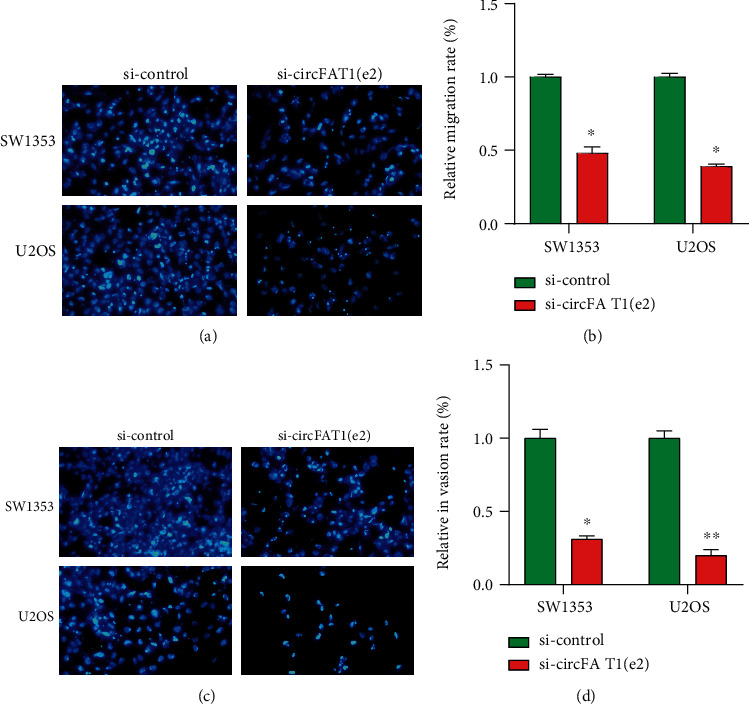
CircFAT1(e2) facilitated osteosarcoma cell migration and invasion. (a, b) In the migration experiments on SW1353 and U2OS cells, the migration rate of circFAT1(e2) knockdown cells decreased by 50% compared with the control group. (c, d) In the SW1353 and U2OS cell invasion experiments, the invasion rate of the control group was 3 to 4 times that of the circFAT1(e2) knockdown group. Error bars represent the mean ± SD of at least three independent experiments. ∗p < 0.05, ∗∗p < 0.01 vs. control group.